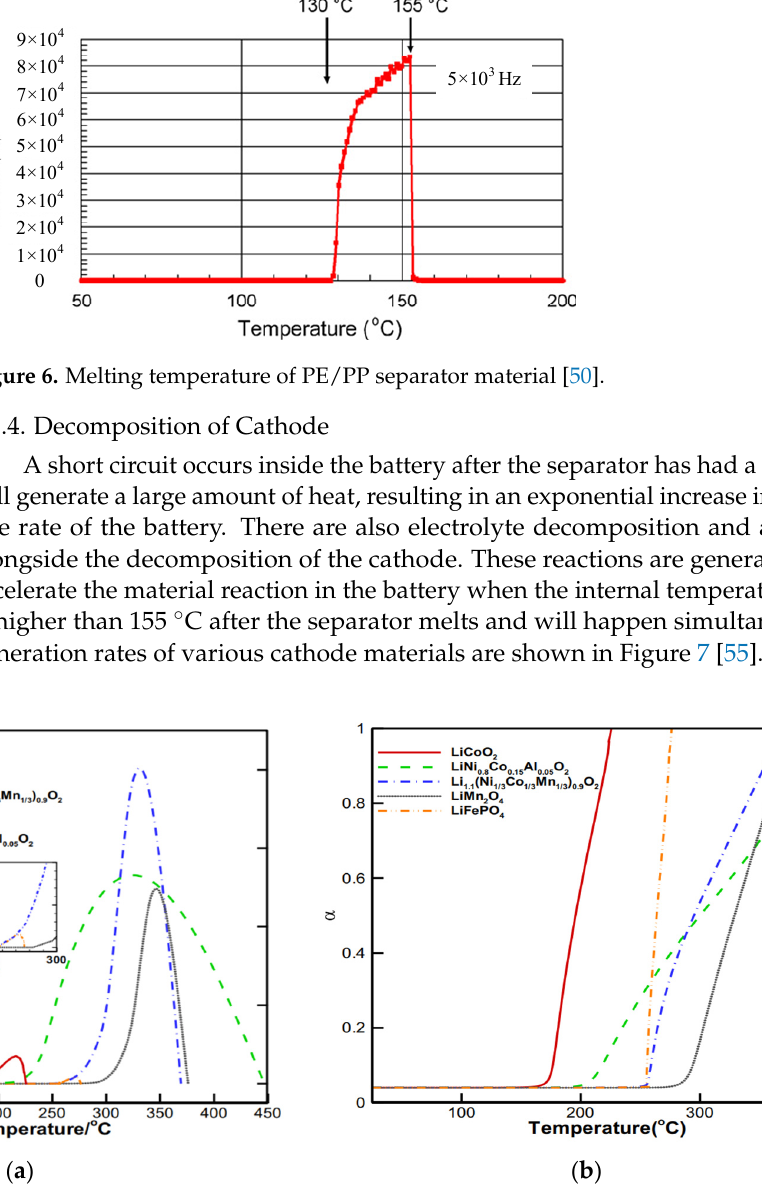
Table 1. Decomposition reactions for different cathode materials [42,56–58].